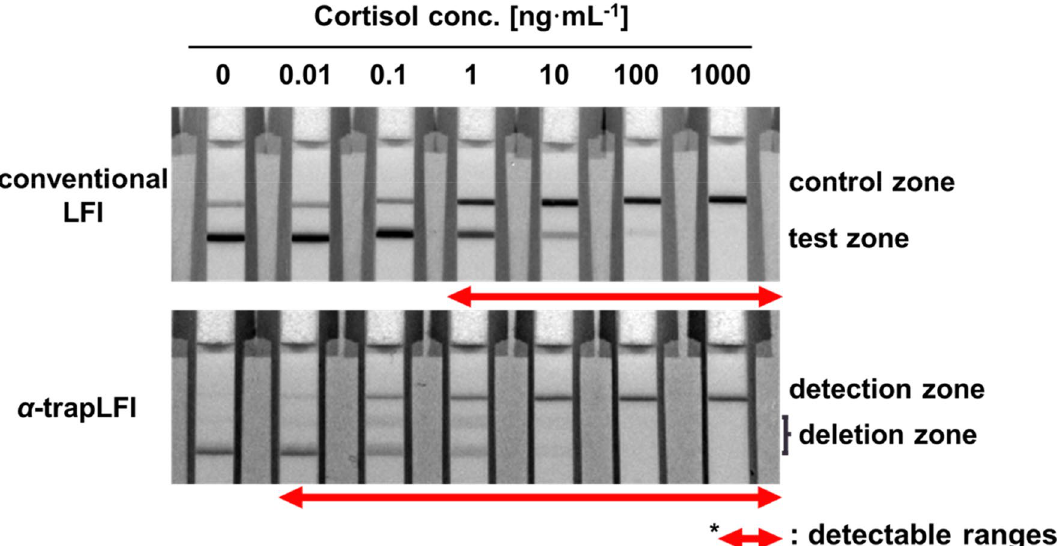
Figure 4. Sensitivity comparisons of the conventional lateral flow immunoassay (LFI) sensor and α -trapLFI sensor. All images were obtained using a ChemiDoc XPS + imaging system (Bio-Rad), and the band intensities were measured using Image Lab software (version 6.1, https:// www. bio- rad. com/ en- uk/ produ ct/ image- lab- softw are? source_ wt= image labso ftware_ surl& ID= KRE6P